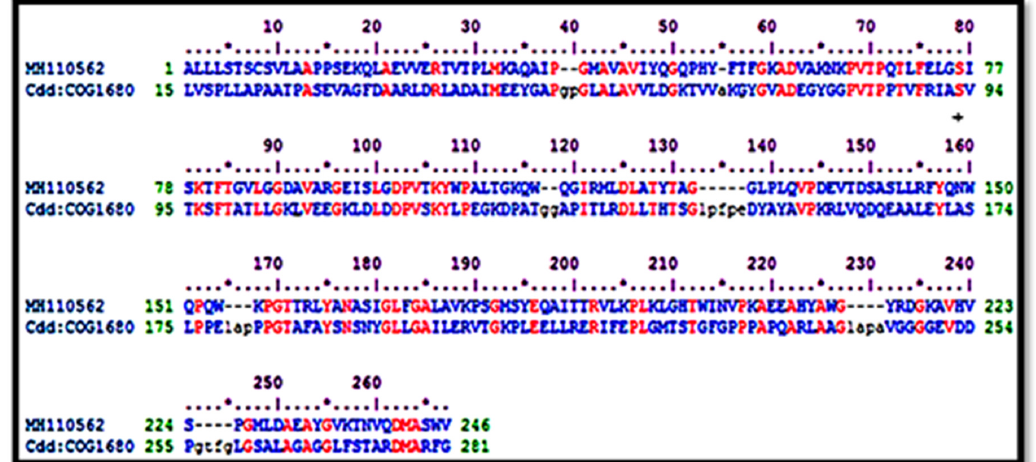
Figure 1. RPS-BLAST pair-wise sequence alignments between the AmpC beta-lactamase amino acid residues of cubic O group peptidase consensus sequence (COG1680) and the query AmpC beta- lactamase amino acid residues (AXH01353) derived from the translated nucleotide sequence (MH110562) of E . cloacae HK 14. COG1680 is the accession number of the specific hit (cubic O group peptidase conserved domain database. (+) symbol indicate the specific location of the serine active site within the highly conserved motifs. (- - - -) indicate regions of amino acid sequence deletions in the AmpC beta-lactamase enzyme due to mutations in the query translated nucleotide sequence. The BLAST was implemented with the conserved domain bioinformatics tool (CD SEARCH/cdd